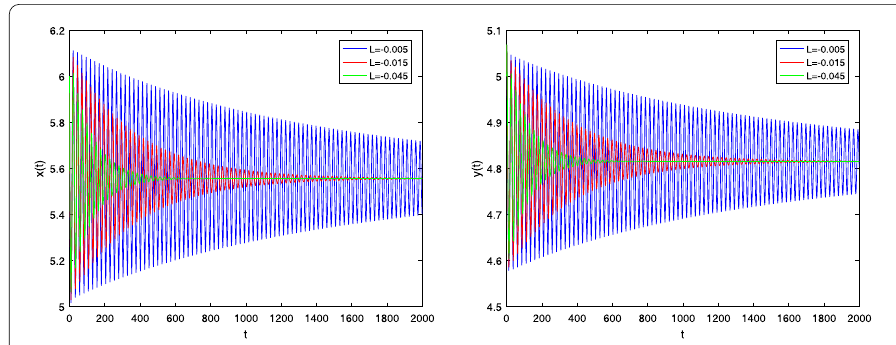
Figure 5 Waveform plots of system (4.24) with initial values (6.46,5.1) in Example 2. This figure illustrates the control effects for the pulse width p = 10 and three different average control gain L = –0.005,–0.015,–0.045